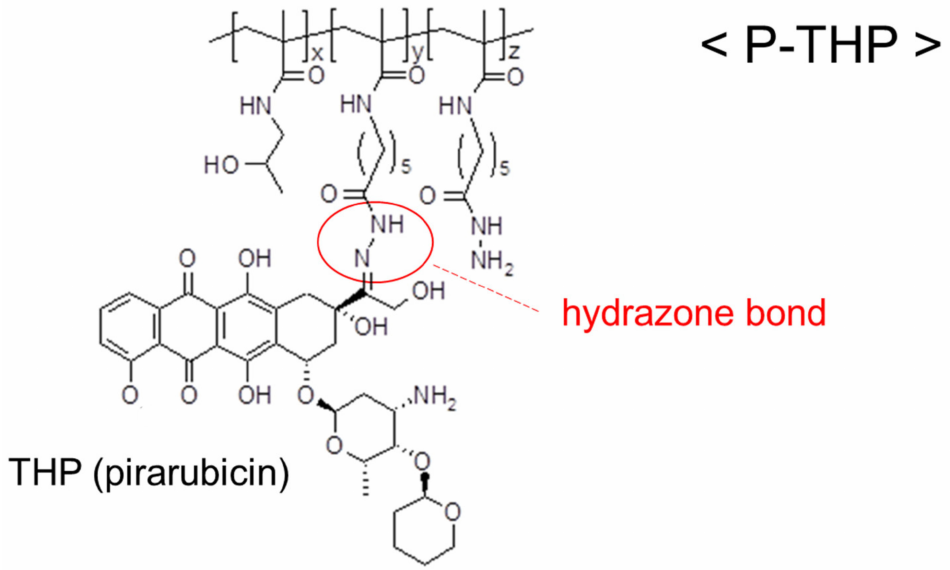
Figure 4. Chemical structure of hydroxypropyl-acrylamide polymer-conjugated pirarubicin (P-THP). Pirarubicin, the active pharmaceutical ingredient (API), is connected to hydroxypropyl-acrylamide (HPMA) polymer by the hydrazone bond, an acid-cleavable linkage. The structure demonstrates the enhanced permeability and retention (EPR) effect targeting the tumor and the secondary release of the API there exerting the antitumor